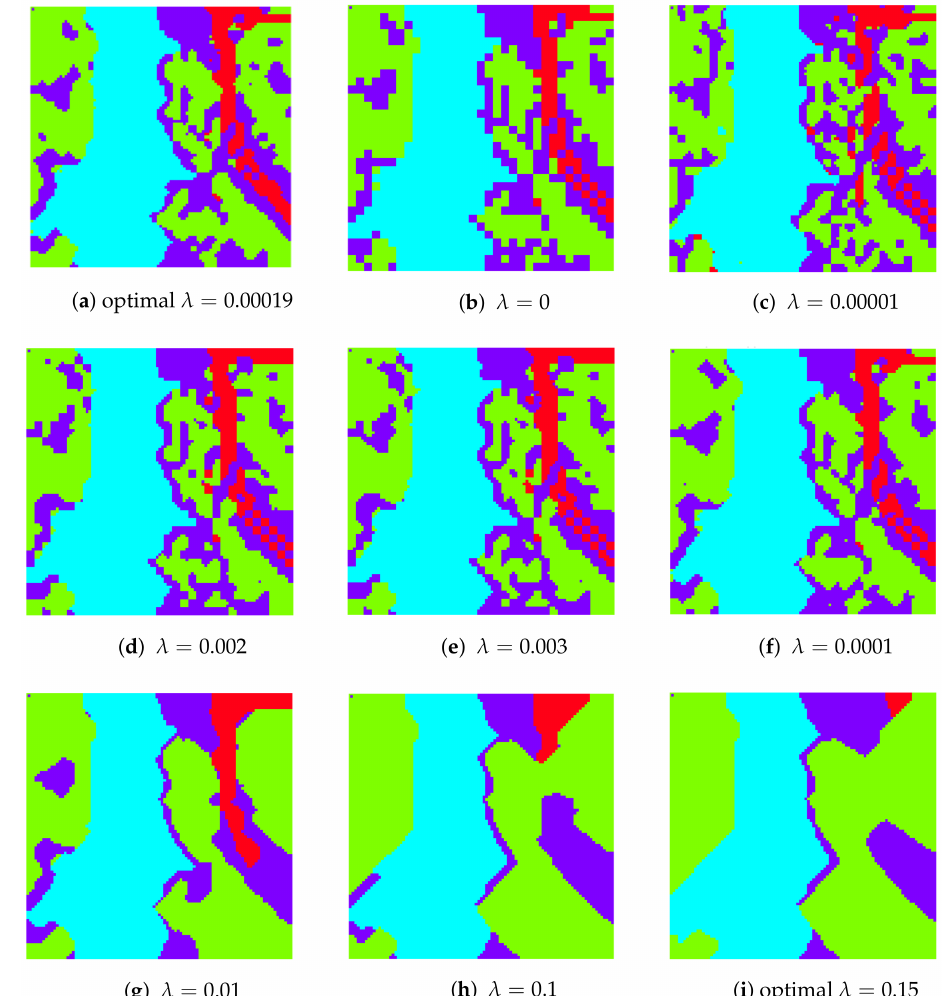
Figure 7. Sub-pixel mapping results obtained by changing λ values.